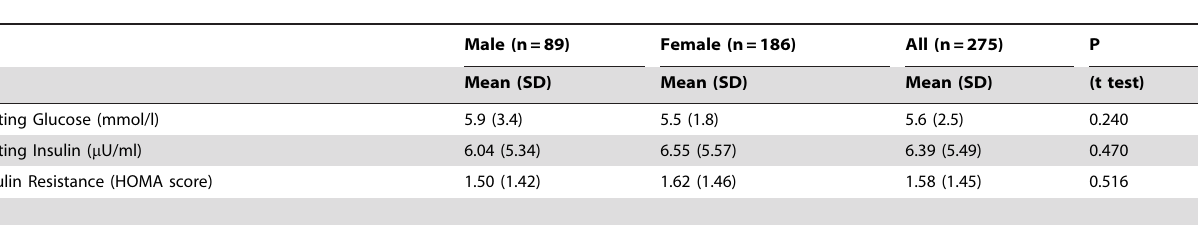
Table 4. The biochemical characteristics of participants by